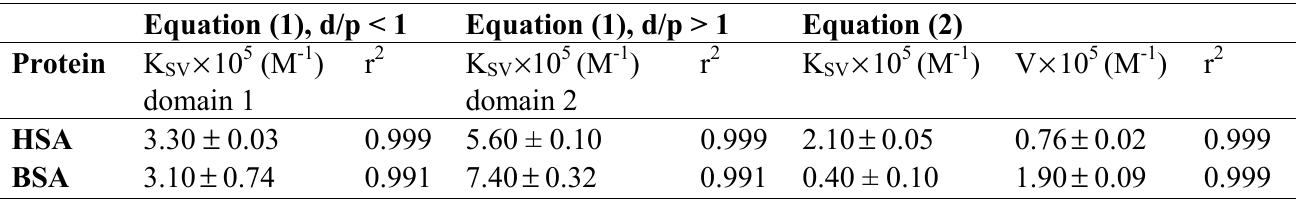
Table 1. Quenching parameters K and V obtained by fitting all the experimental points SV to eq. (2) and considering two linear segment plots for fitting to eq. (1); r 2 represents the correlation coefficients of the